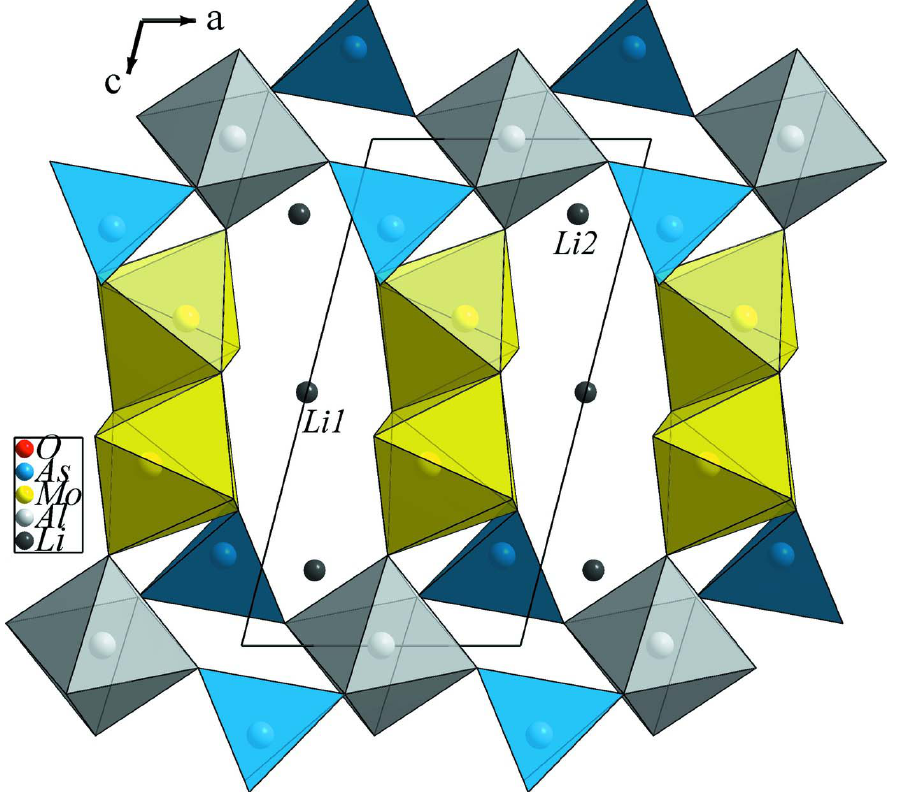
AlMo As O selon a montrant les deux types de canaux où logent les cations Li + 3 2 2 14